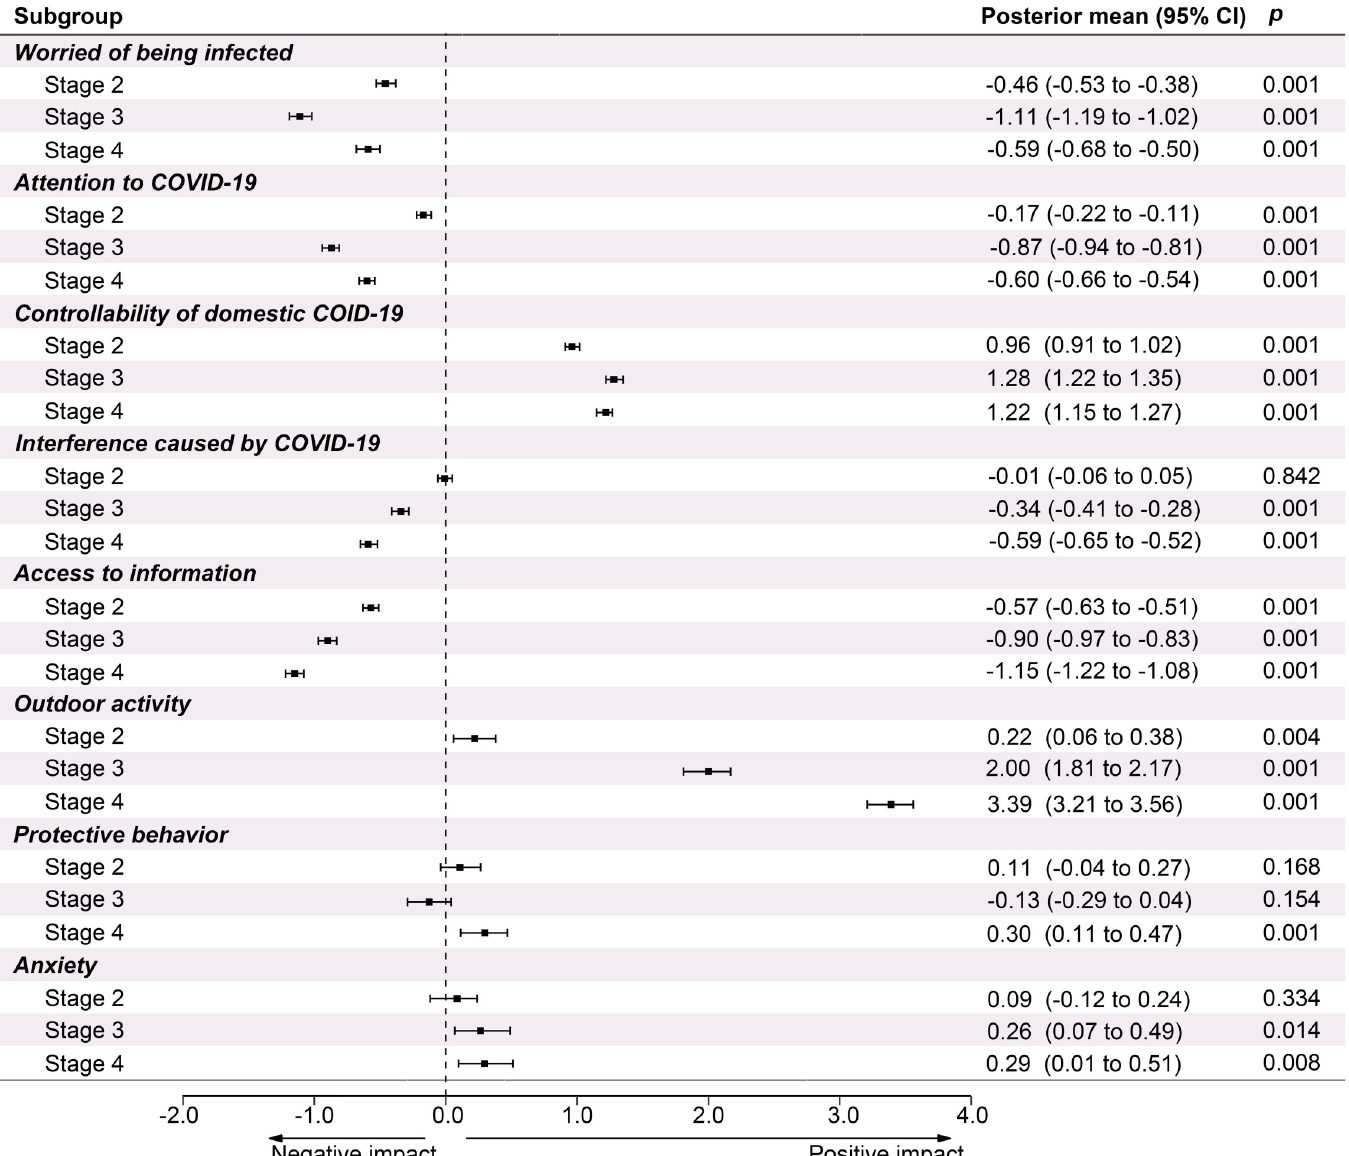
Fig 2. Changes in respondents’ risk perceptions, coping behaviors and anxiety level (95% CI) in different stages compared with Stage 1. Controllability means belief in the controllability of domestic COVID-19 crisis. Access to information means the frequency of access to COVID-related